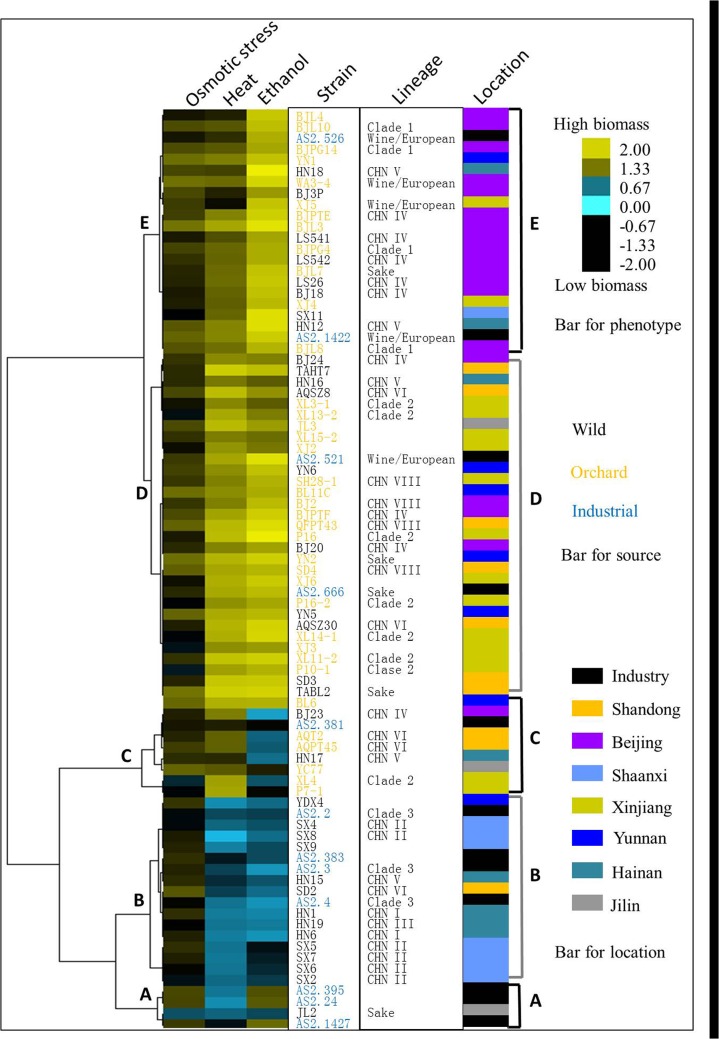
Stress tolerance variations in the S. cerevisiae isolates.Hierarchical clustering of phenotypes was performed using a centered Pearson correlation metric and average linkage mapping. Biomass of strains cultured for 72h in stressful conditions was used to infer stress tolerance. Locations of the isolates were also depicted. The industrial strains from multiple locations were not subdivided.